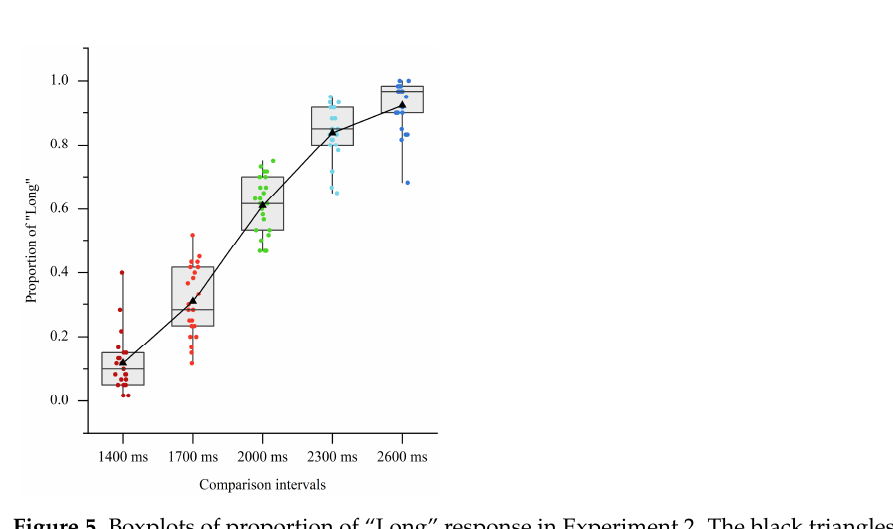
Figure 5. Boxplots of proportion of “Long” response in Experiment 2. The black triangles represent mean values.